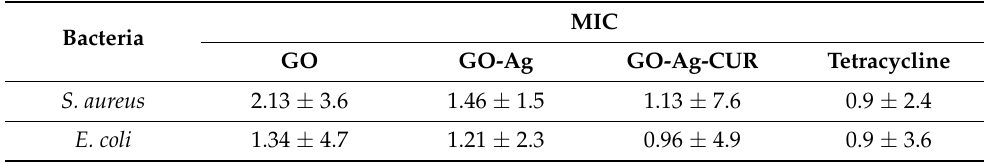
Table 5. MIC values of GO, GO-Ag, and GO-Ag-CUR nanostructures.